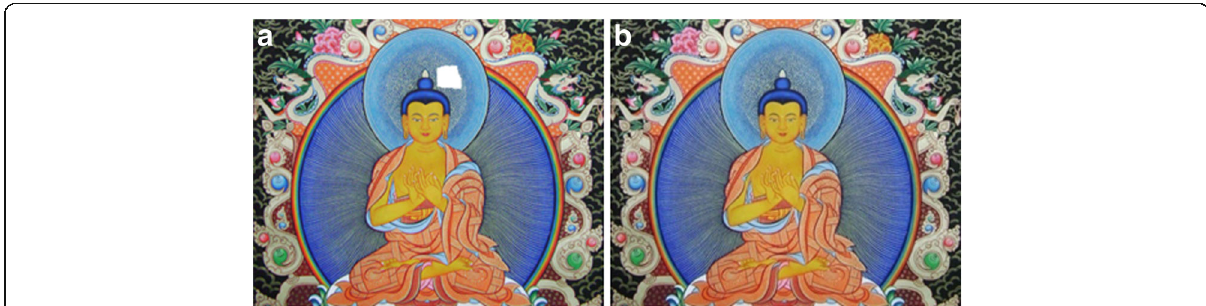
Fig. 13 Simple texture image inpainting results. a Original input image, missing region is marked in white. b Exemplar-based image inpainting result